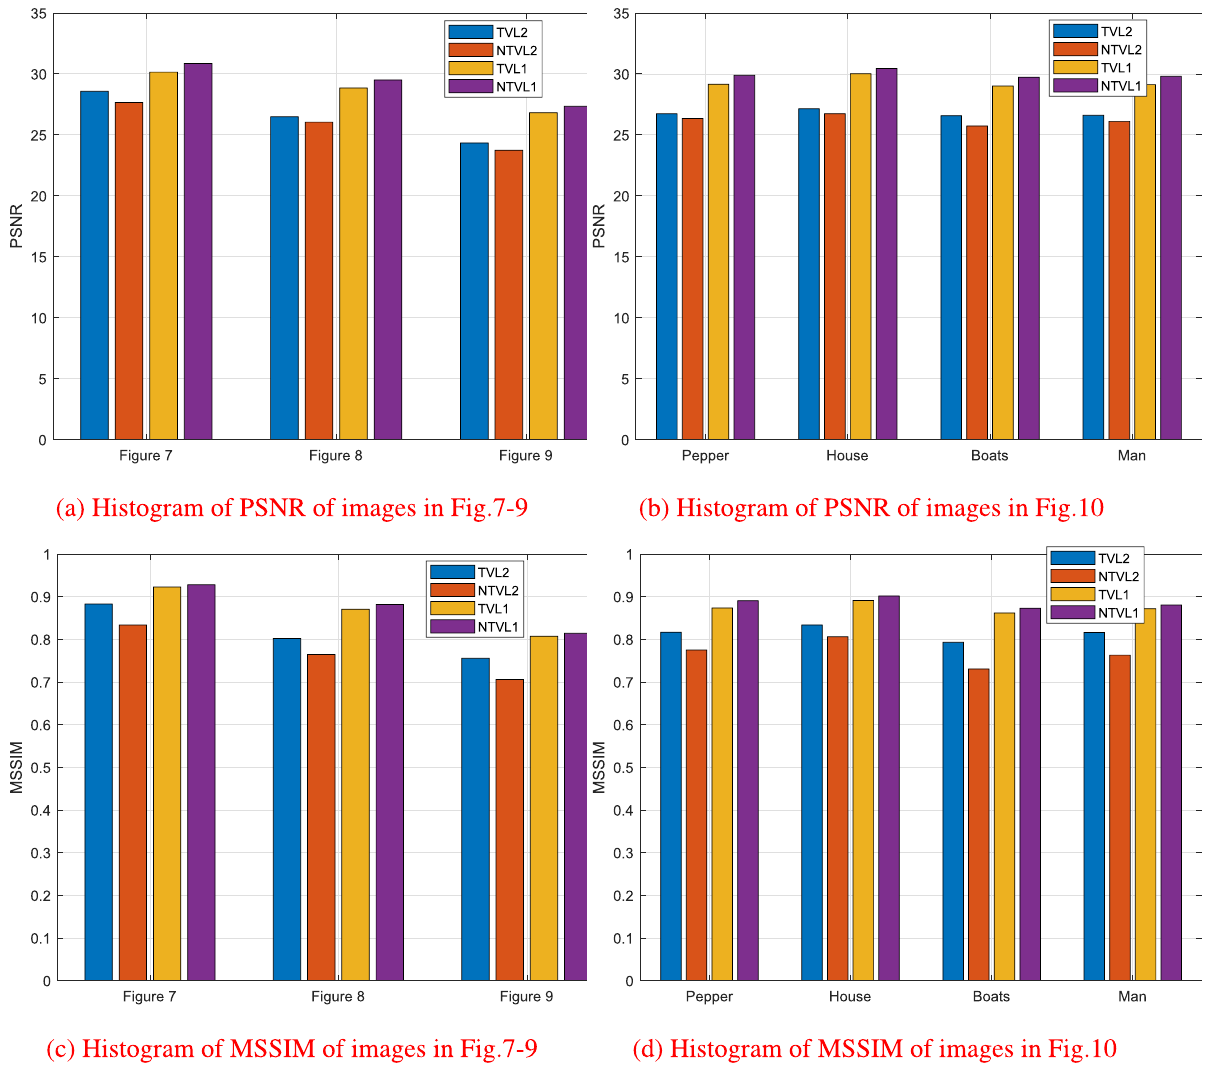
Figure 11. The Histogram of PSNR and MSSIM for different